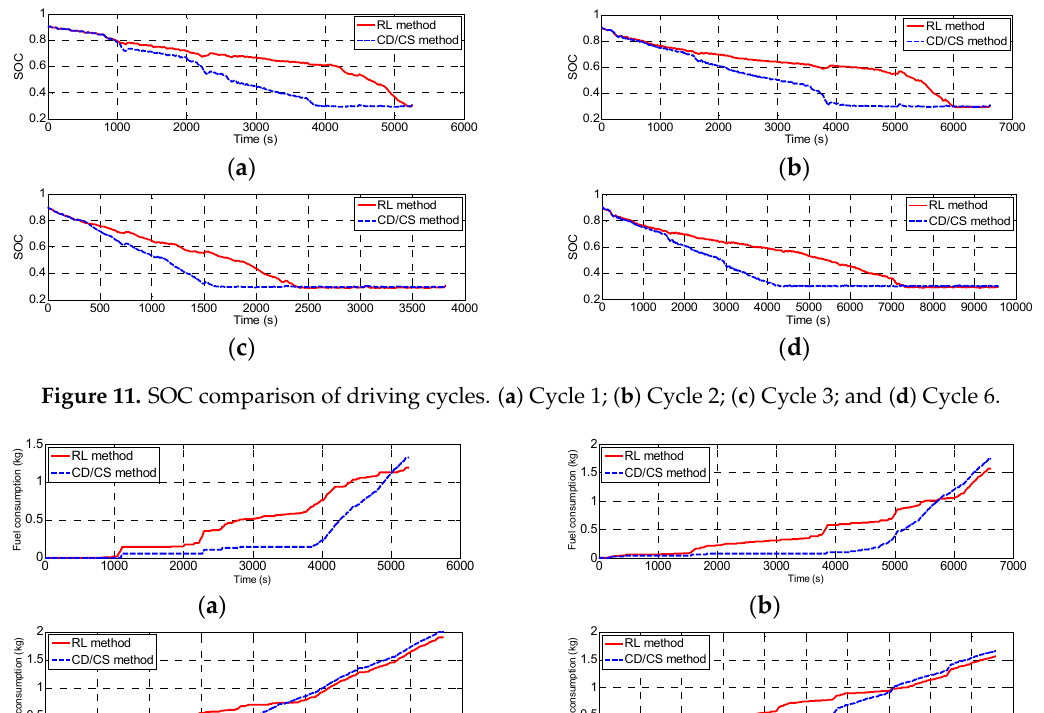
( d ) Figure 10. Battery power comparison under driving cycles. ( a ) Cycle 1; ( b ) Cycle 2; ( c ) Cycle 3; and ( d ) Cycle 6. Figure 11 shows the SOC curve under different driving cycles. The initial SOC is supposed to be 90%, and the minimum SOC threshold is 30%. Compared with the results of the CD/CS scheme, the